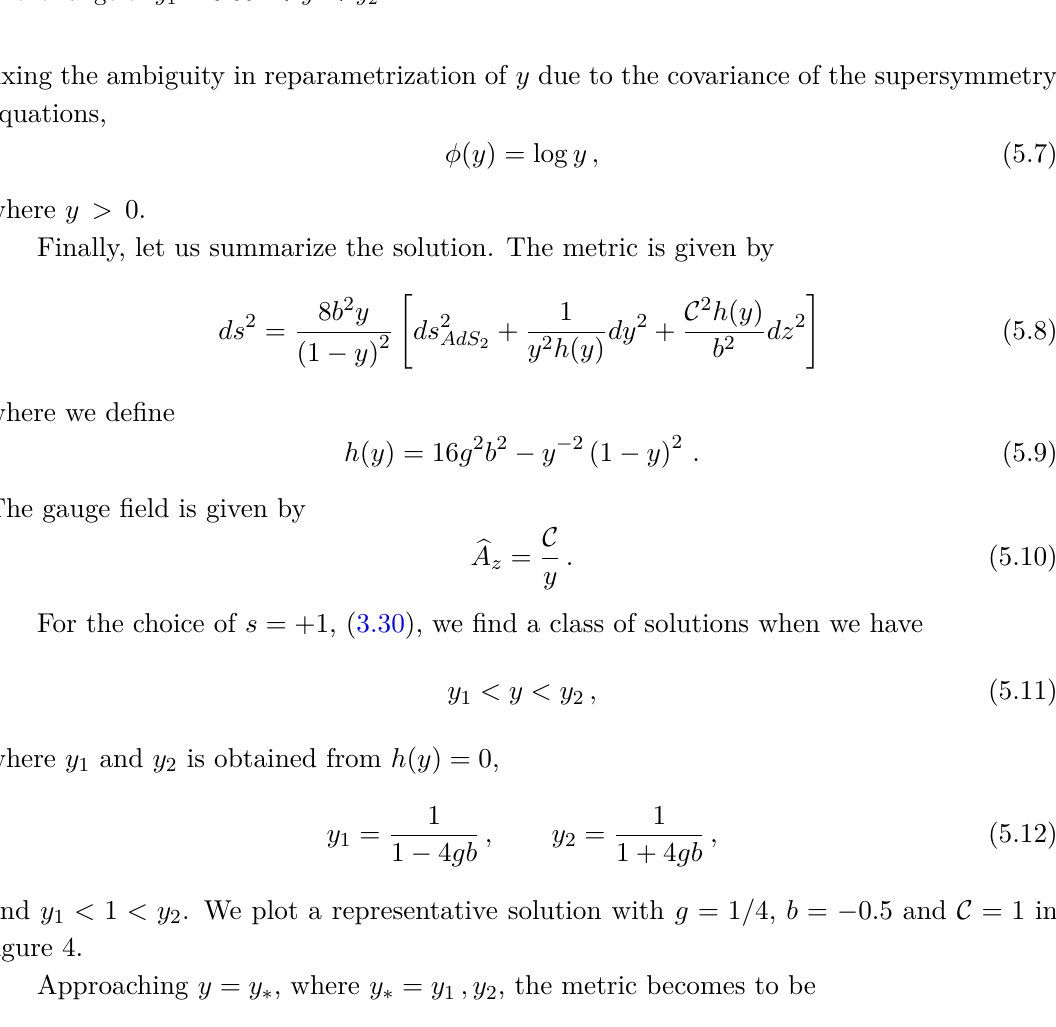
Figure 4 . A representative solution with g = 1 / 4 , b = − 0 . 5 and C = 1 . We consider the solution in the range of y = 0 . 66 < y < y = 2 1 2